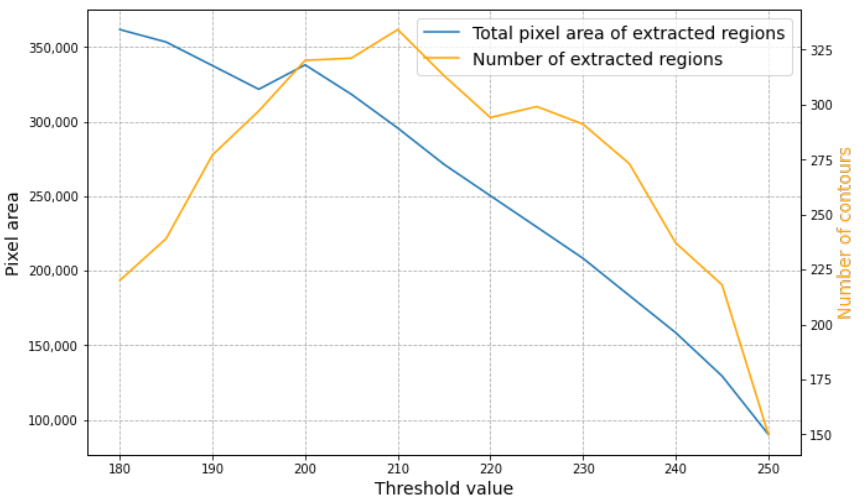
Figure 8. An example of the separation process of the connected rock regions. The new threshold value is chosen based on the total pixel area (blue line) and number of extracted regions (orange line).